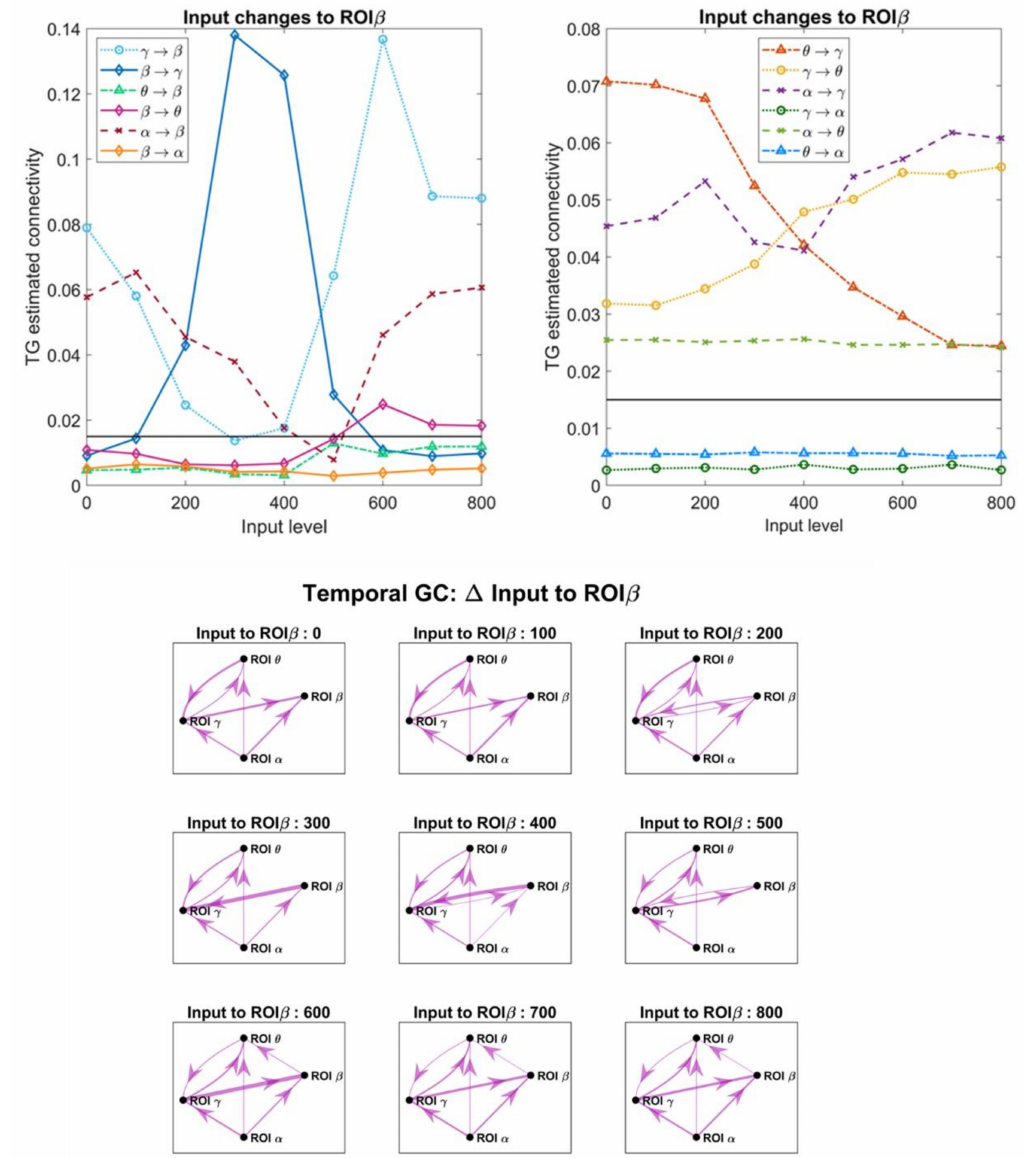
Figure 7. Upper panels: Values of connectivity among the ROIs estimated with the temporal Granger causality, with reference to the network in Figure 2A, when the input to pyramidal neurons in ROI β was progressively varied from 0 to 800, as in the x -axis, and all other inputs and connections were maintained at the basal value, as in Figure 2A. It is worth noting the strong effect that the input change has on the connections which involve the ROI β (in particular the output connection β → γ and the input connection γ → β ). Additionally, the connection between ROI γ and ROI θ is affected. Bottom panels: connectivity graphs obtained from the estimates using a threshold as low as 0.015 (the threshold is depicted as a horizontal black line in the upper